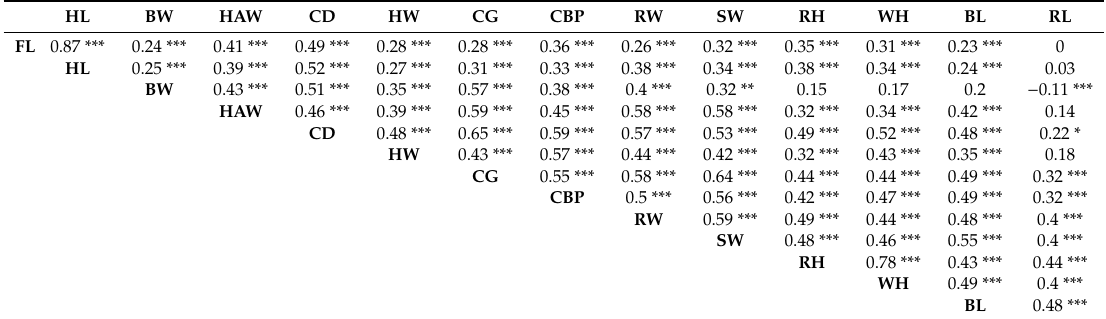
Table 2. Spearman correlation matrix among morphological variables of the Black Creole goat. HL BW HAW